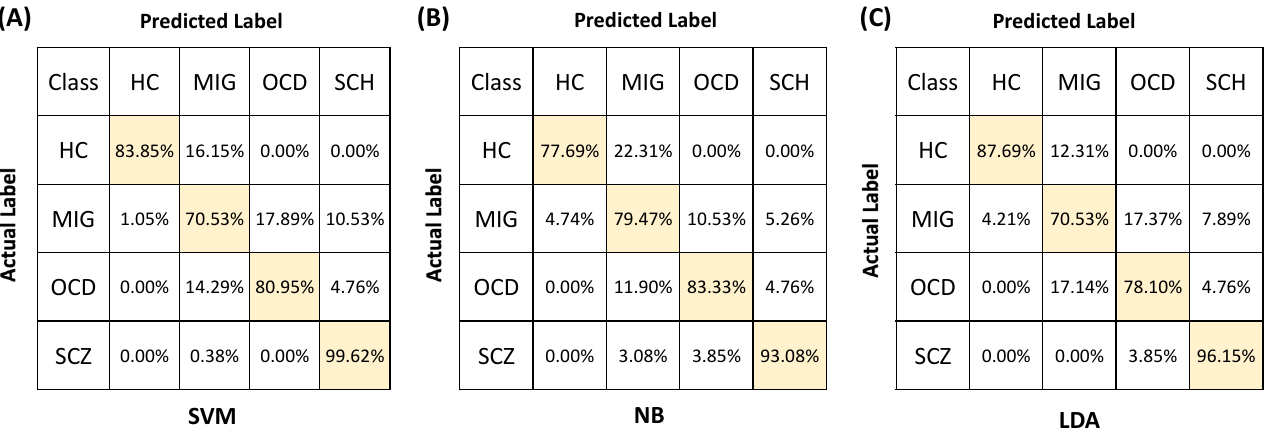
Figure 8. Confusion matrices depicting the true-positive (shaded in yellow) and false-negative predictions of ( A ) SVM, ( B ) NB, ( C ) LDA when they are trained with a combination of fNIRS and behavioral features.